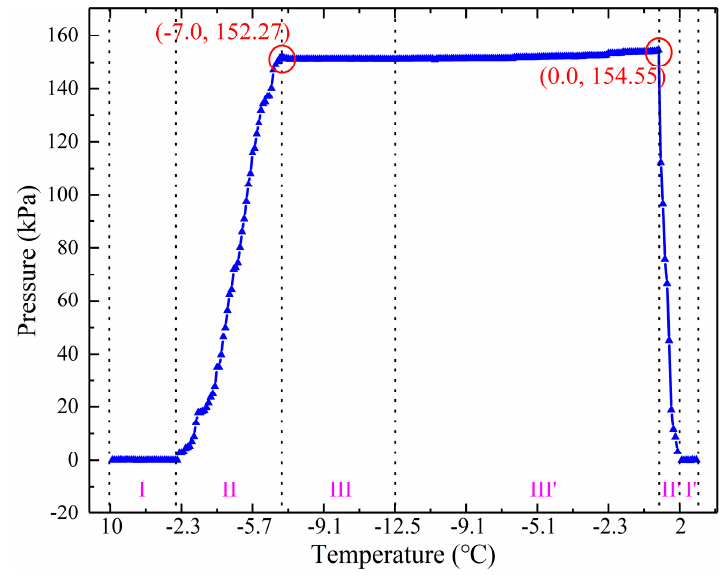
Figure 15. The curve of static ice pressure on the bottom in the growth and melting processes of ice.